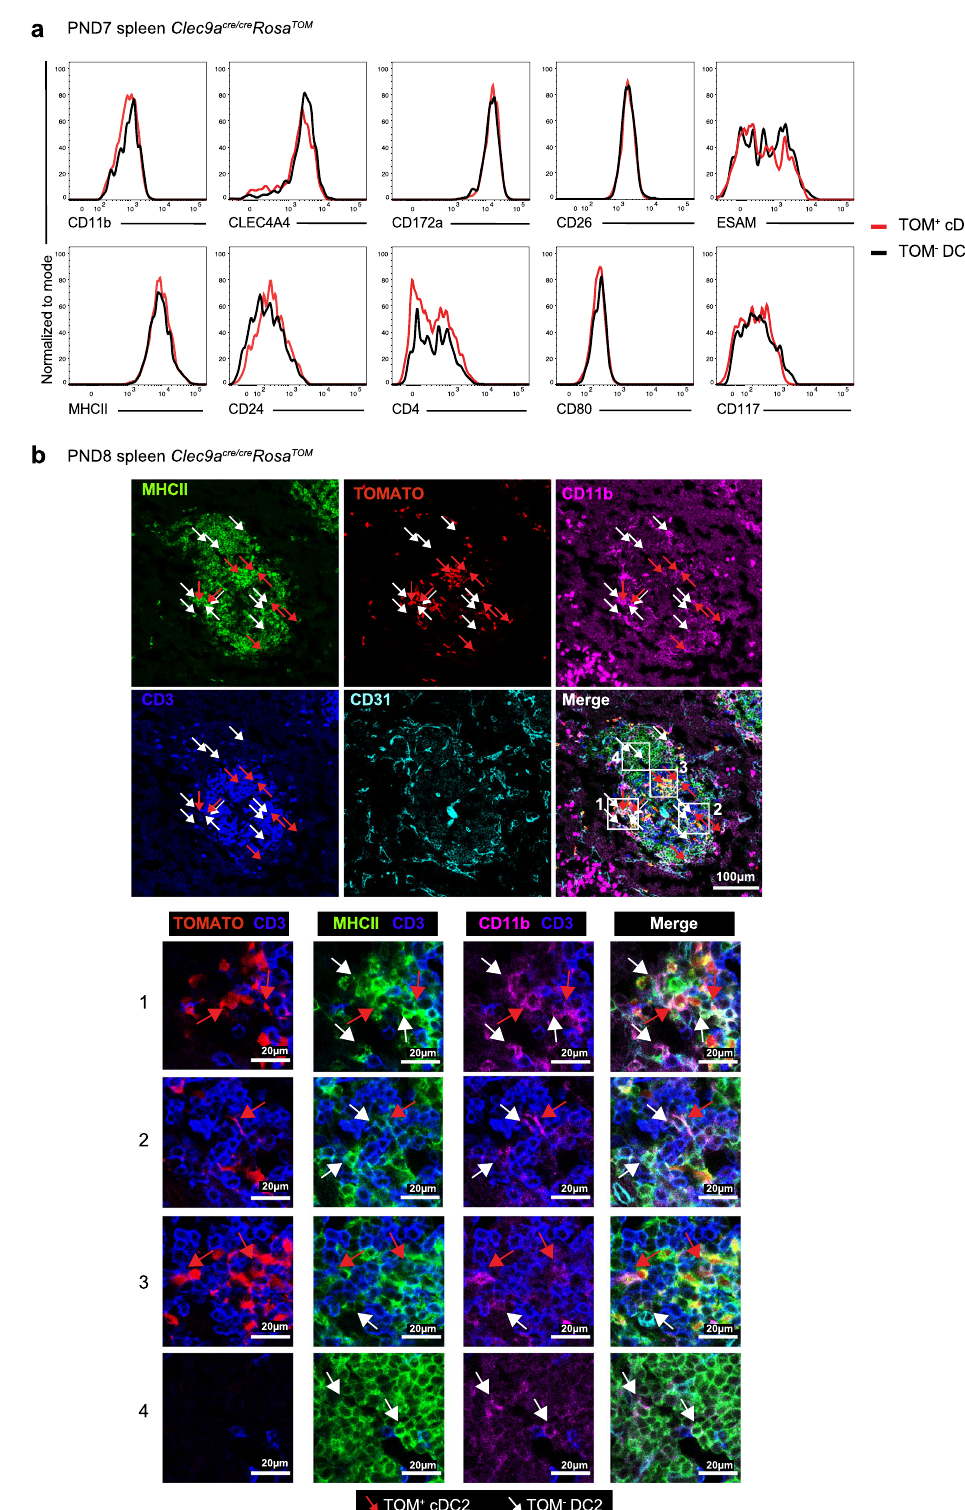
Fig. 3 TOM − DC2 phenotypically resemble TOM + cDC2. a TOM + cDC2 and TOM − DC2 from 1-week-old Clec9a cre/cre Rosa TOM mice were analyzed for expression of the indicated surface markers. Data are representative of at least two independent experiments with four to seven mice. b Spleens from PND8 Clec9a cre/cre Rosa TOM mice were analyzed for expression of CD31 (cyan), CD3 (blue), MHCII (green), TOMATO (red), and CD11b (magenta) by microscopy. Numbered inset squares were magni fi ed on the bottom panels TOM + cDC2 (red arrows) or TOM − DC2 (white arrows) were identi fi ed. Data are representative of two independent experiments with three biological